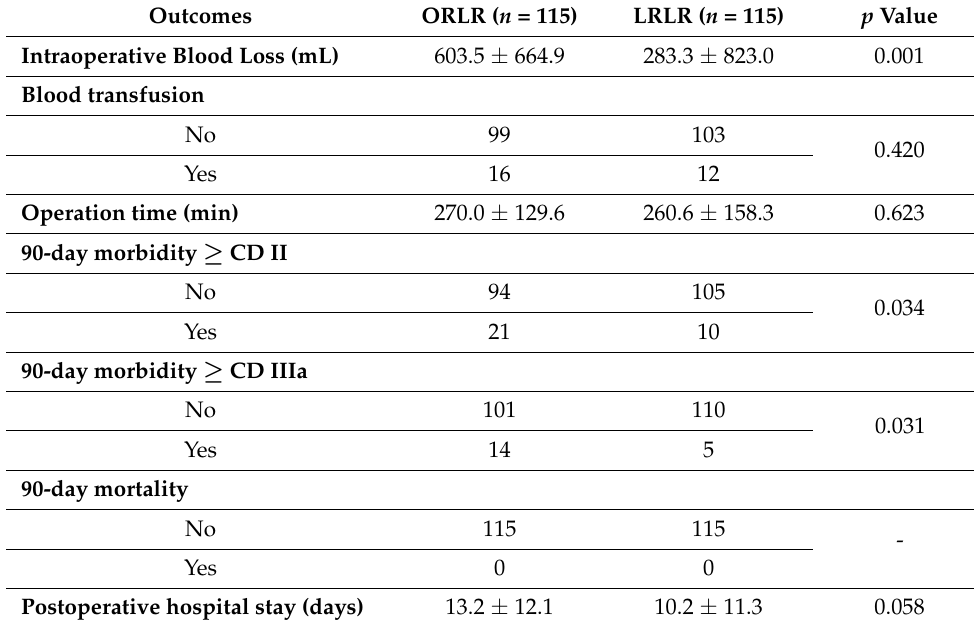
Table 4. Short-term outcomes after propensity score